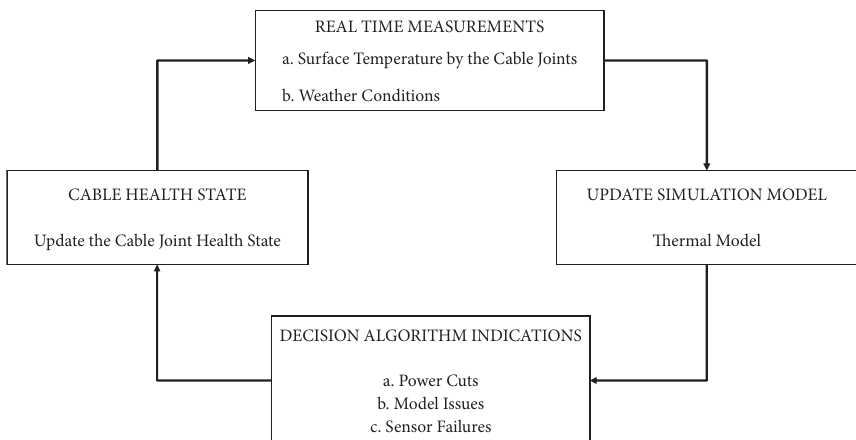
Figure 3: Thermal monitoring